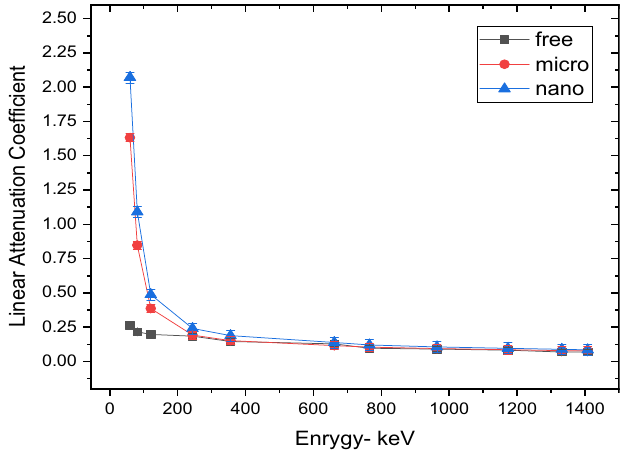
Figure 6. Comparison between LAC for free silicon rubber nano- and micro-SnO 2 for 20wt% at different energy photon.